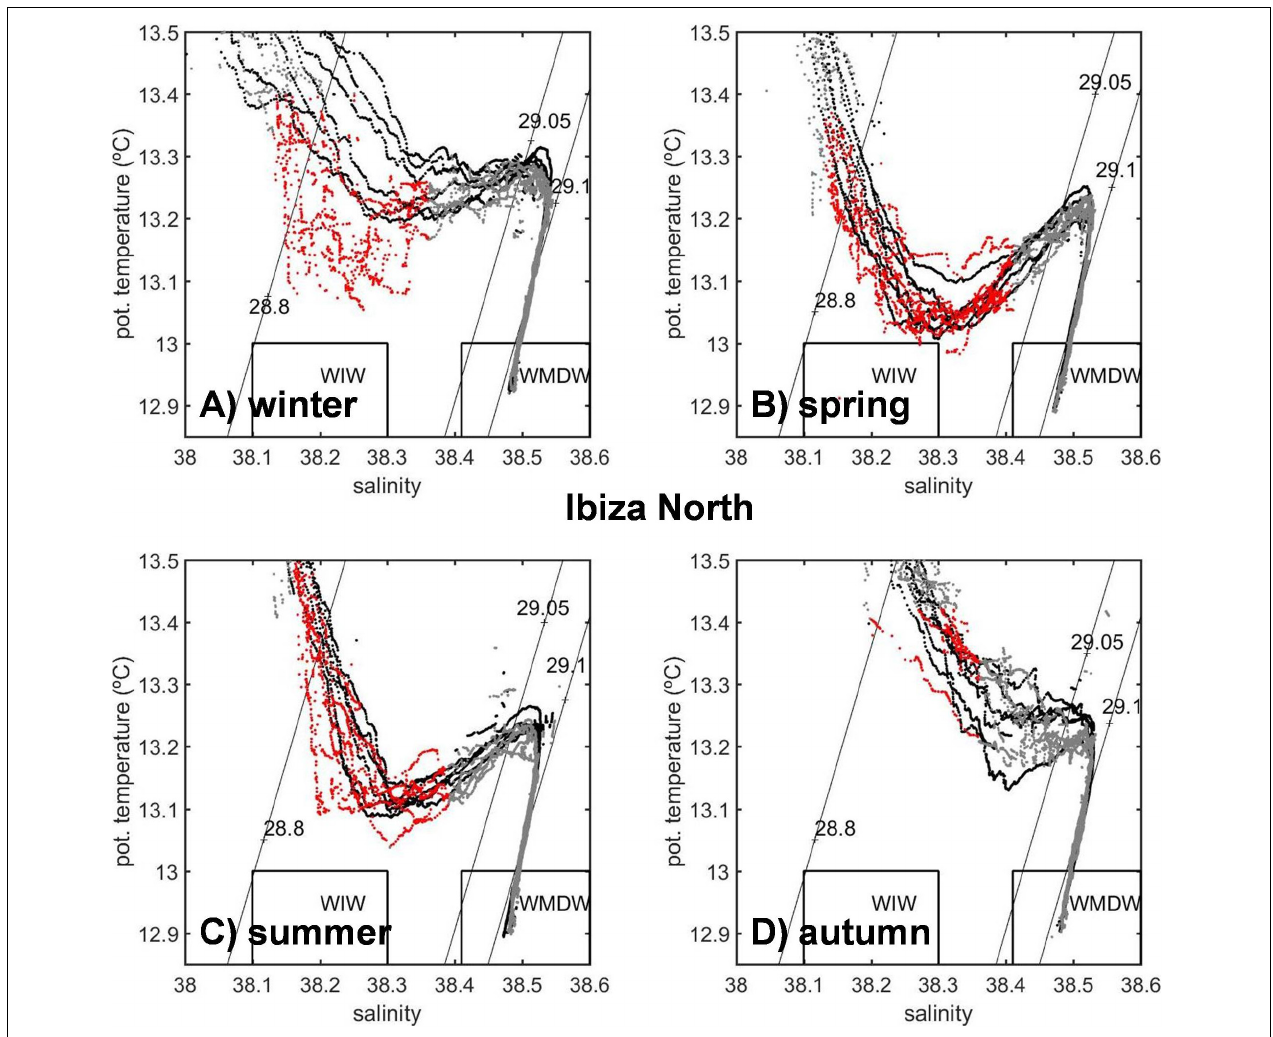
FIGURE 9 | Same as Figure 7 for the Ibiza North section. Winter (A) , Spring (B) , Summer (C) , Autumn (D)